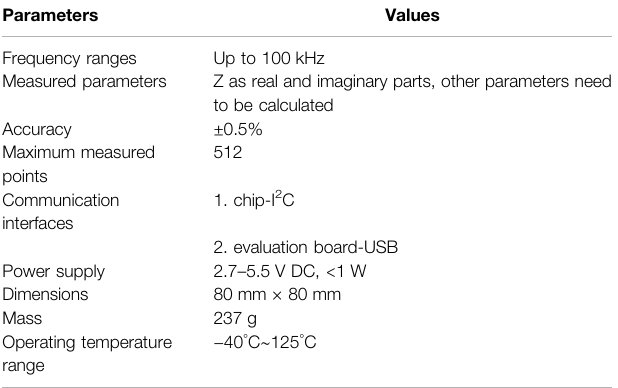
TABLE 1 | Technical speci fi cation for AD5933. Parameters Values Frequency ranges Up to 100 kHz Measured parameters Z as real and imaginary parts, other parameters need to be calculated Accuracy ± 0.5% Maximum measured